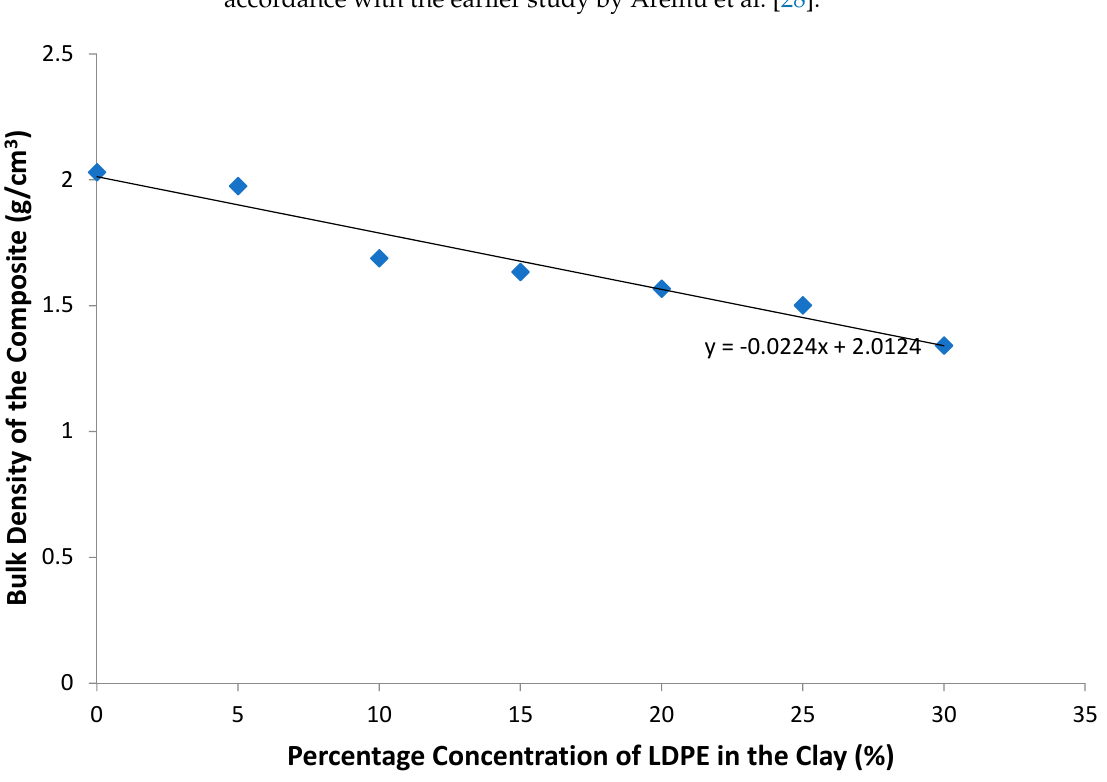
Figure 2. Variation of bulk density of the clay-polyethylene composites.